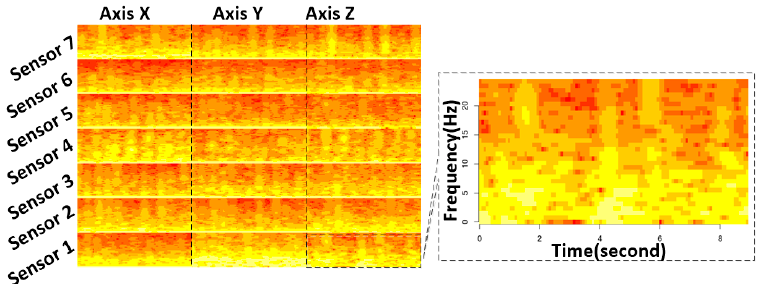
Figure 4. Spectrogram plot of the acceleration data. The segment length is 512 and the sampling rate is 50 Hz, with a short-time Fourier transform (STFT) window length of 64 STFT and an overlap length of 60 STFT (image resolution 336 × 350